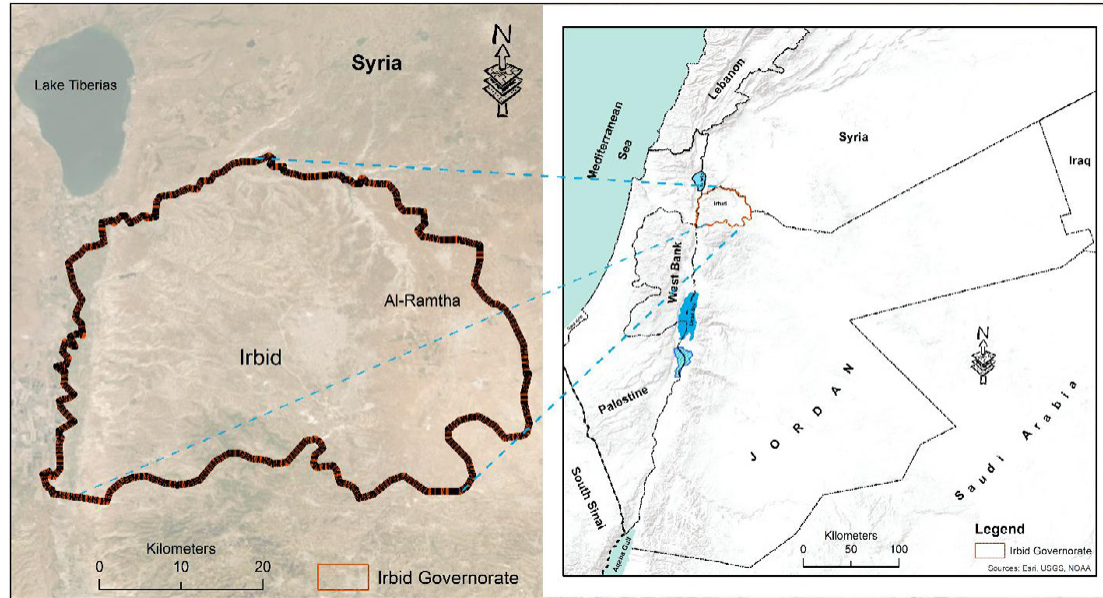
Fig. 1: Geographic location of the study area in Irbid governorate, Jordan